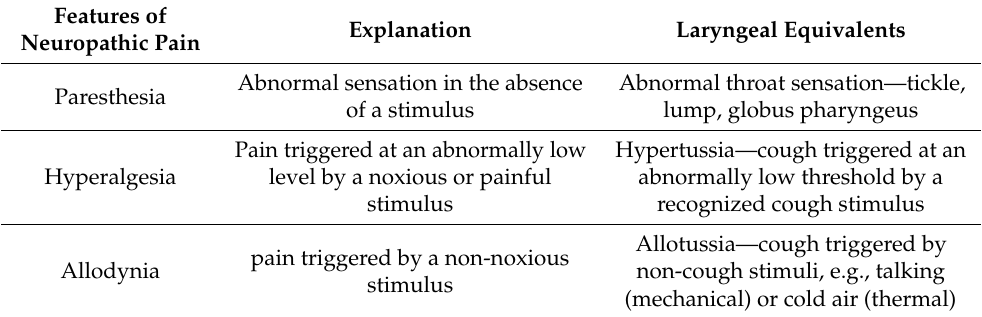
Table 1. Equivalent laryngeal features of neuropathic